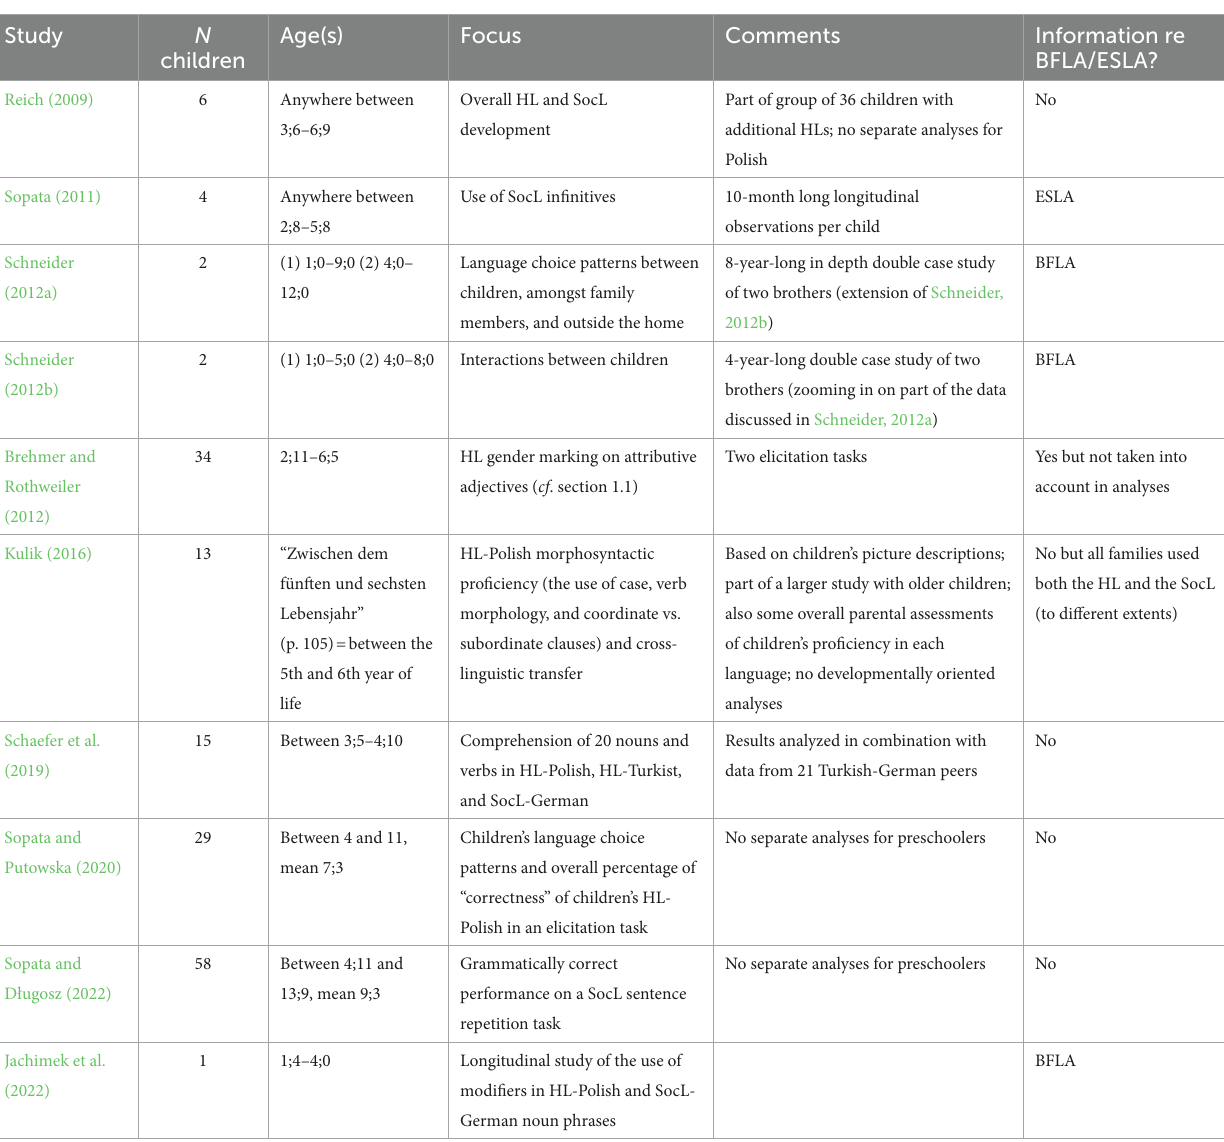
TABLE 1 Studies involving Polish-German preschoolers in Germany *